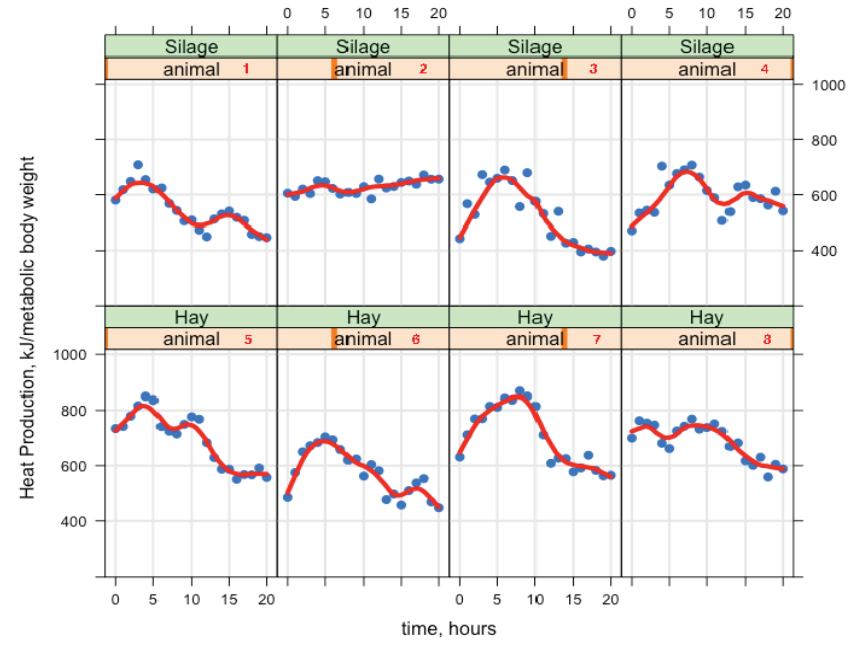
Figure 3. Heat production in 8 lactating dairy goats consuming diets composed of 40% forage (either alfalfa hay [Hay] or alfalfa silage [Silage]) and 60% of concentrate; observation data (points) and smooth regression (solid line).